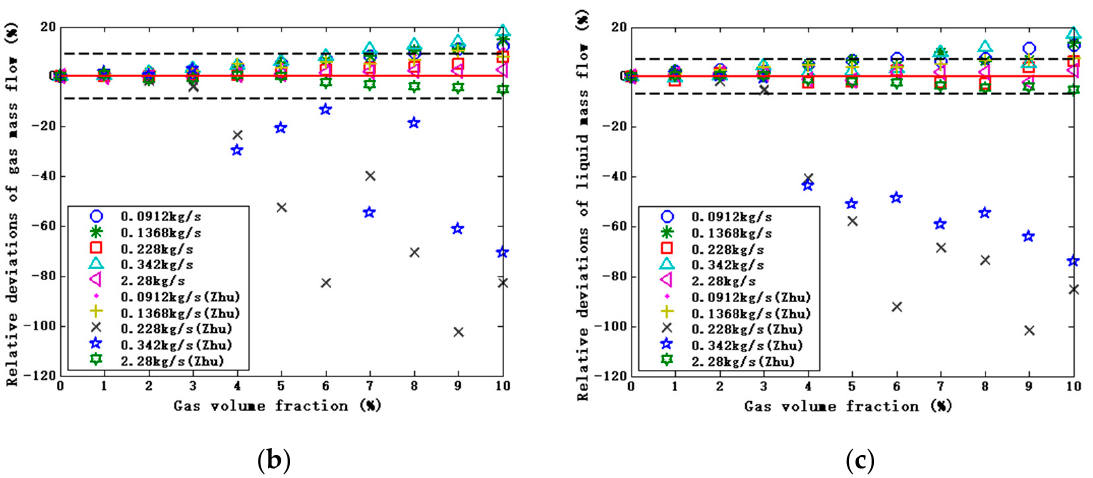
Figure 11. Comparison of each-phase measurement deviation correction results of stratified flow between the uniform bubble flow correction model and the proposed correction model. ( a ) Gas-phase content. ( b ) Comparison of relative deviations of gas-phase mass flow. ( c ) Comparison of relative deviations of liquid-phase mass flow.